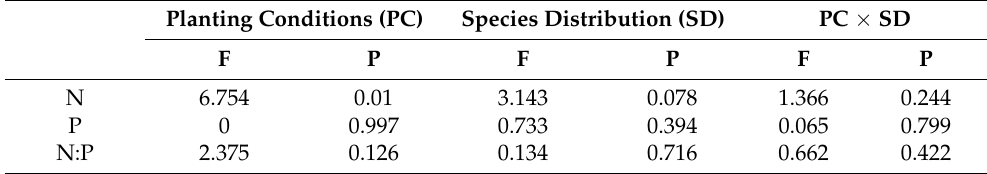
Table 1. The effect of mycorrhiza type, planting condition, species distribution and their interaction on the N, P, and N:P ratio in AM and ECM plants based on linear mixed effect models planting conditions, species distribution and their interaction are fixed effects. Mycorrhizal type is random effects. Planting Conditions